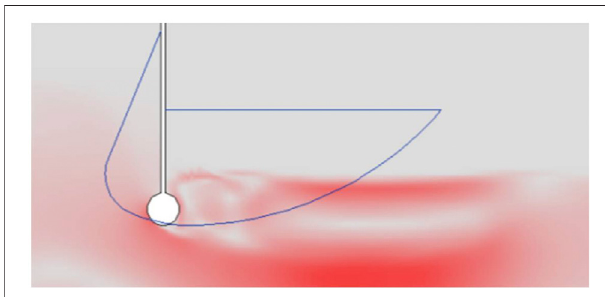
FIGURE3| Illustrationof fi naldesignofthenewoutlet fl owshaper(blueline) superimposed on velocity fi eld (gray to red scale where red is high velocity and turbulence) from a numerical model of the original outlet (white circle) during crest generation ( fl ow out of the fi rst generation TS into the fl ume, left to right).